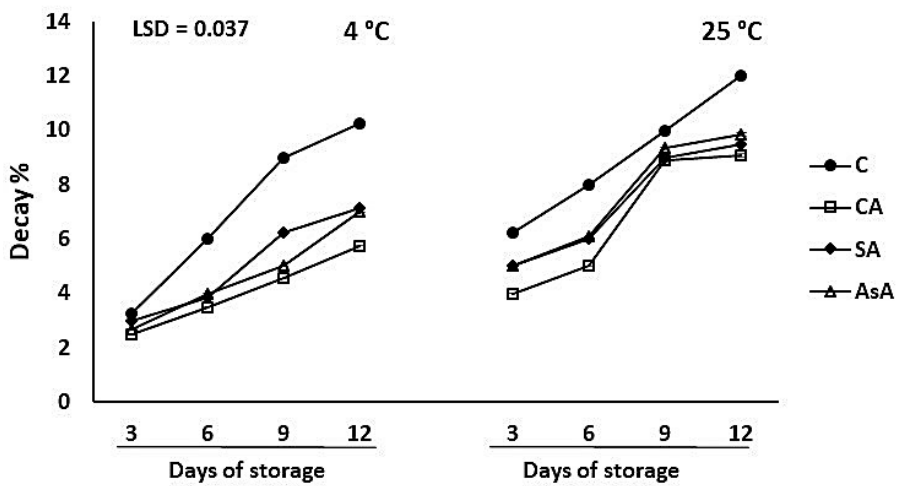
Figure 4. Effects of bio-stimulants B, control (C), citric acid (CA), salicylic acid (SA) and ascorbic acid (AsA), storage period SP (3, 6, 9 and 12 days) and storage temperature T (4 ◦ C and 25 ◦ C) on decay % of okra pods. Error bars are the ± SD of the means of three biological replicates for each temperature condition. LSD values ( p ≤ 0.05) for B = 0.01, SP = 0.01, T = 0.00, B × SP = 0.03, B × T = 0.02 and SP × T = 0.02. LSD for B ×SP ×T is shown on the figure.